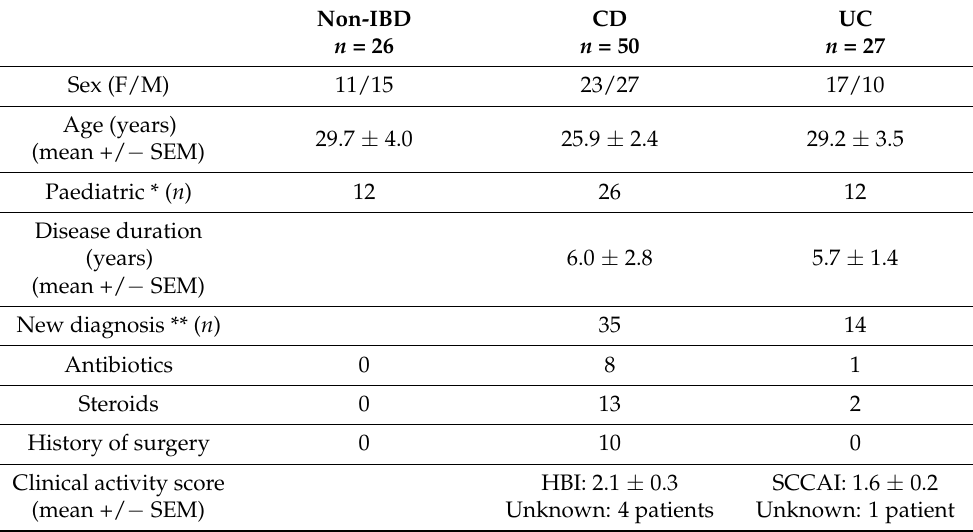
Table 1. Patients’ characteristics. IBD: Inflammatory bowel disease; CD: Crohn’s disease; UC: Ulcera- tive Colitis; F: Female, M: Male; SEM: Standard error of the mean. * Paediatric: patients < 18 years